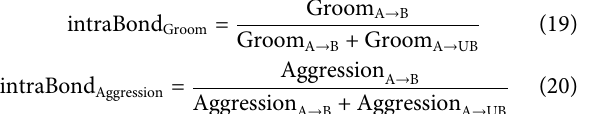
Frontiers in Robotics and AI |